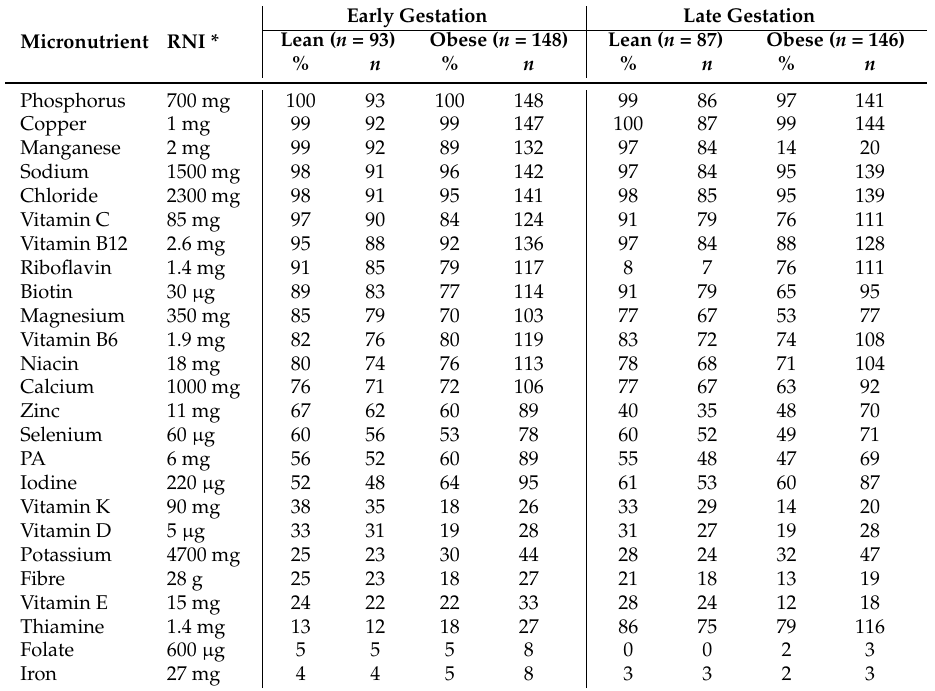
Table 5. Percentage of lean and obese women achieving recommended nutrient intakes (RNI) in early & late gestation.